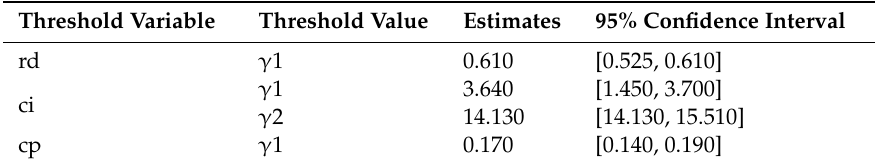
Table 10. Threshold estimation results and confidence intervals for stock market value and carbon emissions.